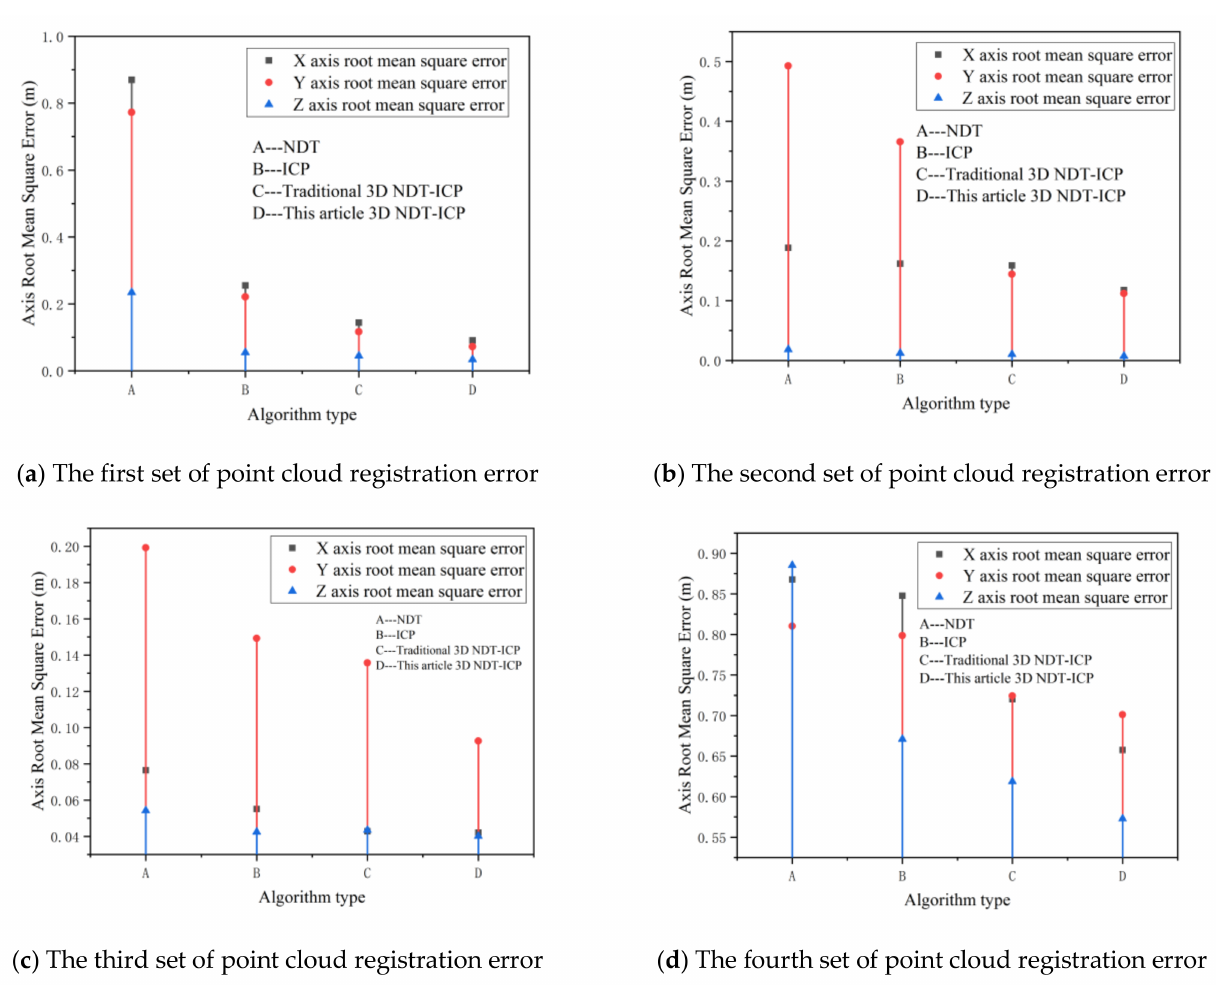
Figure 13. Point cloud registration error.